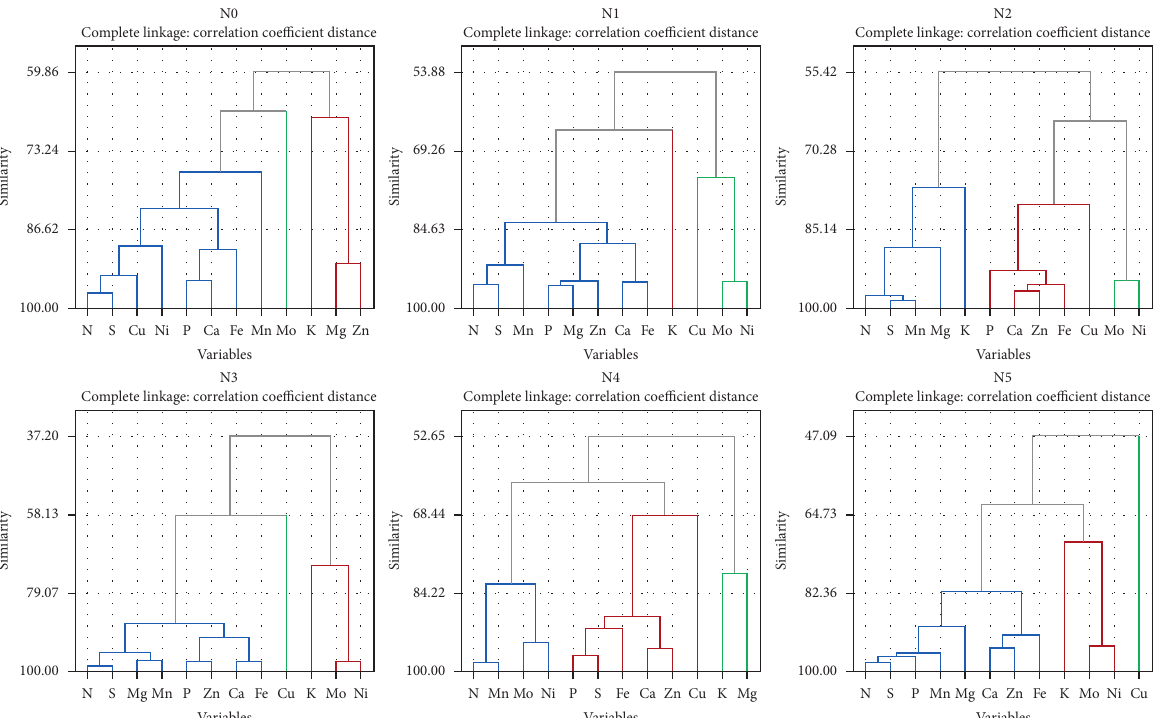
Figure 3: Cluster of NPK in nutrients with means of sampling times on stalk. Nitrogen (N), potassium (K), phosphorus (P), magnesium (Mg), calcium (Ca), sulphur (S), zinc (Zn), iron (Fe), copper (Cu), manganese (Mn), nickel (Ni), and molybdenum